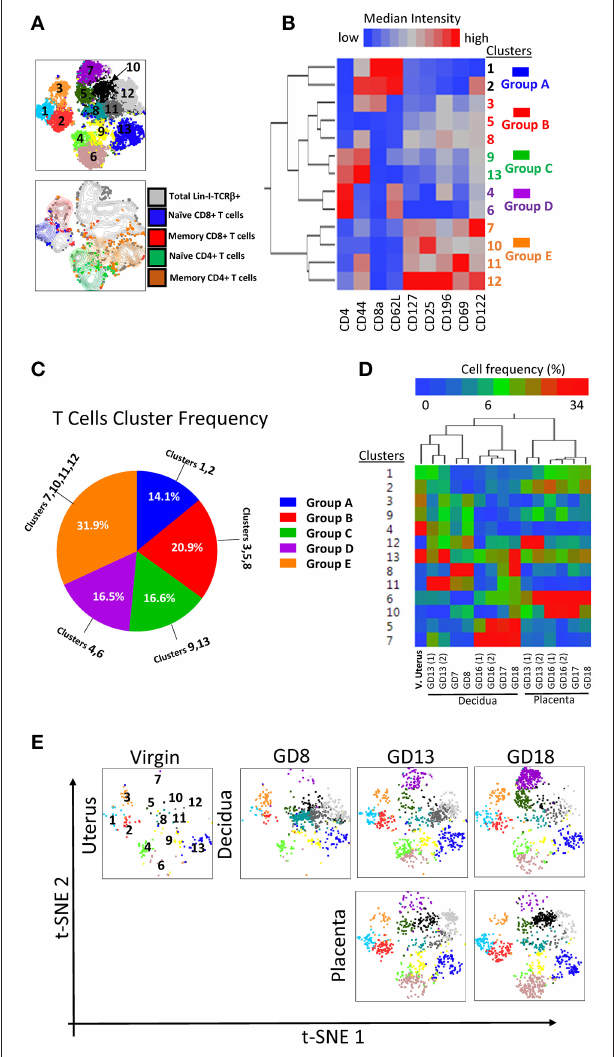
TABLE 2 | Presumed classification of I-A/I-E + clusters ( Figure 6B ).